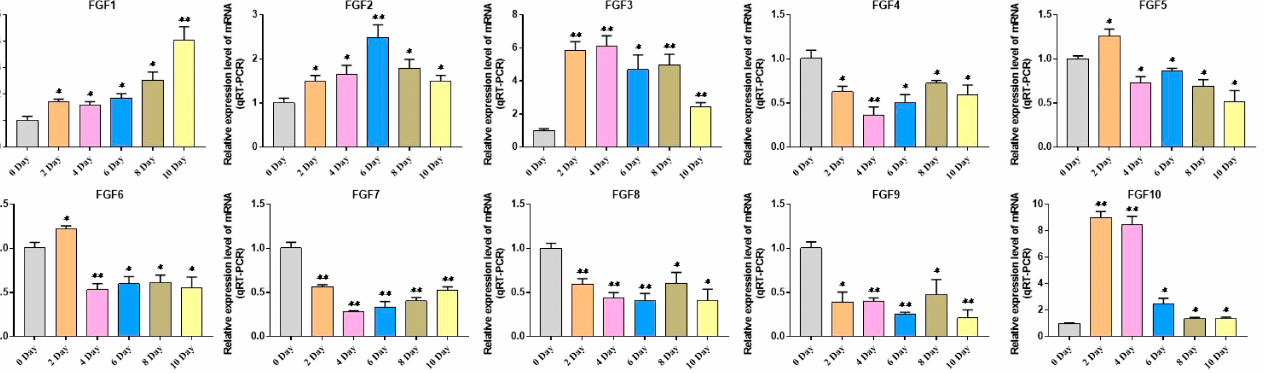
Figure 8. Detection of FGFs gene expression during adipocyte di ff erentiation. Compared with the control, “*” means a signi fi cant di ff erence ( p < 0.05), “**” means an extremely signi fi cant di ff erence ( p < 0.01), and “N.S.” indicates a non-signi fi cant di ff erence. 3. Discussion Beef is one of the most important meat products in daily life, and the content of IMF directly a ff ects its taste and fl avor, so it is of great signi fi cance to explore the molecular mechanism a ff ecting IMF deposition. In recent years, with the completion of whole ge- nome sequencing of animals and plants, a large number of studies on gene families have been reported. Fibroblast growth factor (FGF) transduces signals through fi broblast growth factor receptor (FGFR) tyrosine kinase, which mainly regulates the development and morphogenesis of many tissues by paracrine or autocrine actions [15–17]. Consider- ing the potential role of FGF family members and the fact that only a small number of FGF family members have been reported in other species [17,18], we believe that it is very im- portant to identify and analyze the FGF gene family in ca tt le. 3.1. Identi fi cation and Phylogenetic Analysis of Bovine FGF Family Proteins In this study, we used the 49 identi fi ed human, mouse, and bovine FGF protein se- quences as references to retrieve FGF genes in the Bos taurus (22), Bos indicus (19), Hybrid- Bos taurus (20), Hybrid-Bos indicus (21), Bos grunniens (20), Bubalus bubalis (22), Bos mutus (16), and Bison bison bison (18) genomes based on sequence similarity and conserved struc- tural domains. The di ff erence in the number of FGF gene family members may be related to the genome size and ploidy level [19]. Previous studies have found that Caenorhabditis elegans has only two FGF genes, whereas 22, 22, 27, and 35 FGF genes were identi fi ed in the genomes of human, mouse, zebra fi sh, and common carp, respectively, indicating that